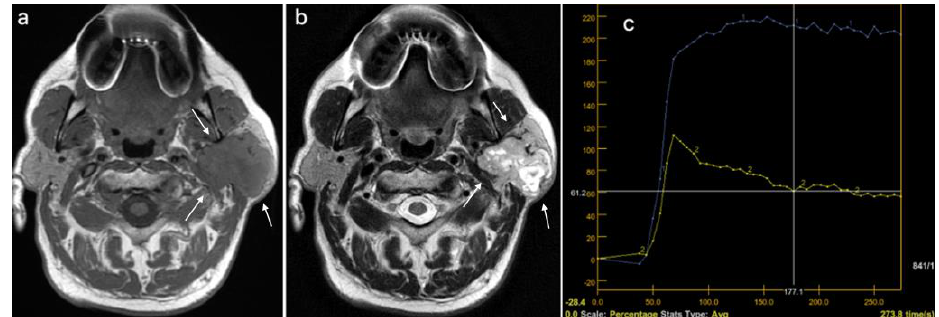
Figure 3. Pleomorphic adenoma of the left parotid gland (white arrows): ( a ) T1WI sequence showing a hypointense signal in the lobulated lesion, well delineated; ( b ) T2WI sequence showing an inho- mogeneous, predominantly hyperintense signal in the tumor, with central cystic areas; ( c ) DCE-MRI showing a type A TIC curve.